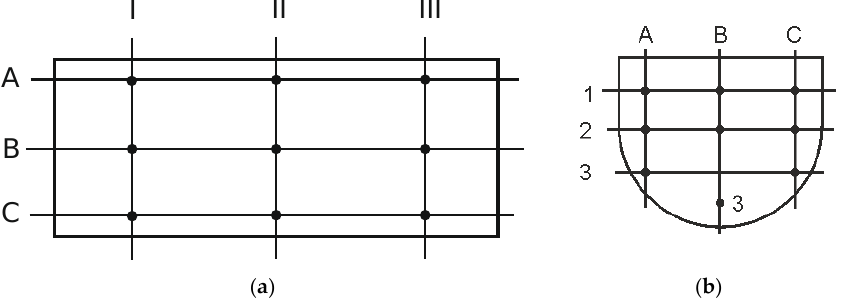
Figure 5. Sites the samples were collected for determination of the product homogeneity coefficient after mixing: ( a ) in the horizontal plane; ( b ) in the vertical plane.